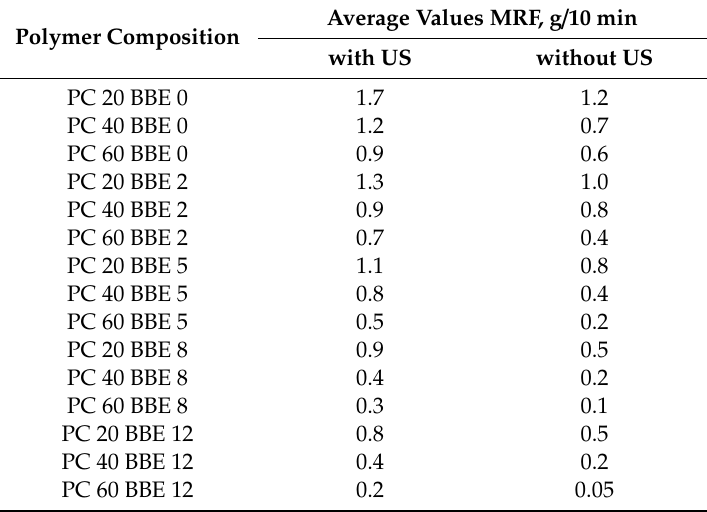
Table 8. Dependance of the melt flow rate index (MRF) on the composition of polymeric compositions material, received with (with US) and without the use of ultrasonic treatment (without US). Average Values MRF, g / 10 min Polymer Composition